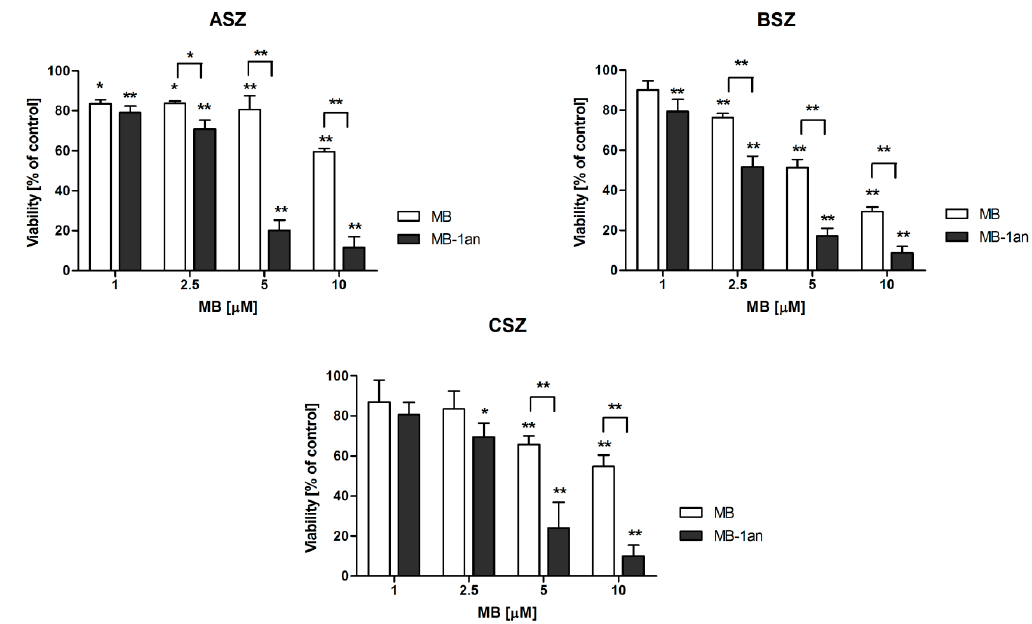
Figure 4. Viability of ASZ, BSZ and CSZ cell lines after the treatment with different concentrations of MB and MB-1an after the 30 min irradiation. The light source was a Q.Light Pro Unit (Q.Products AG, Rorschach, Switzerland) lamp. * p < 0.05, ** p < 0.001.